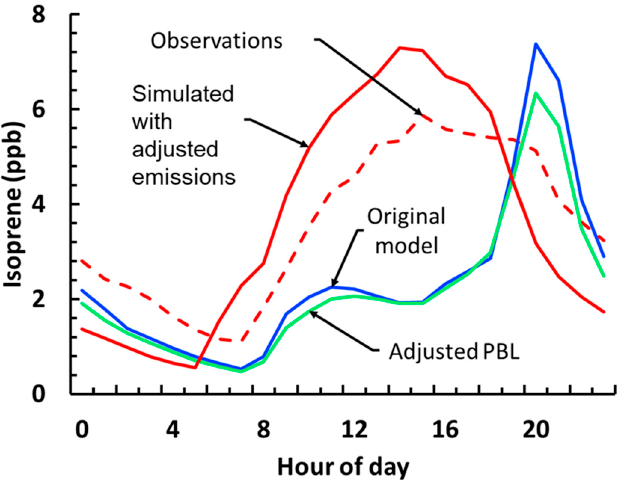
Figure 3. Observed (dashed-red), default model (blue), adjusted planetary boundary layer height (PBL, green) and adjusted PBL and emissions (solid red) isoprene diurnal profiles for the Centreville gridcell. Concentrations at each hour correspond to the campaign average for that hour.